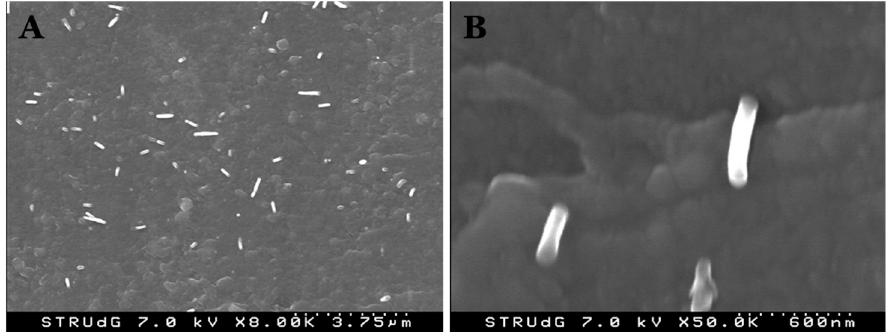
Figure 5. Field emission scanning electron microscopy (FE-SEM) images of the fracture surface at low ( A ) and high ( B ) magnification.